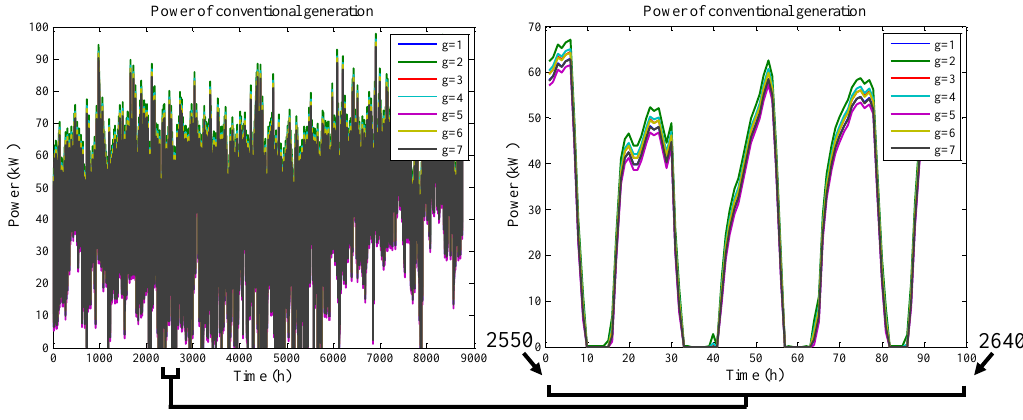
Figure 23. Conventional power time series.